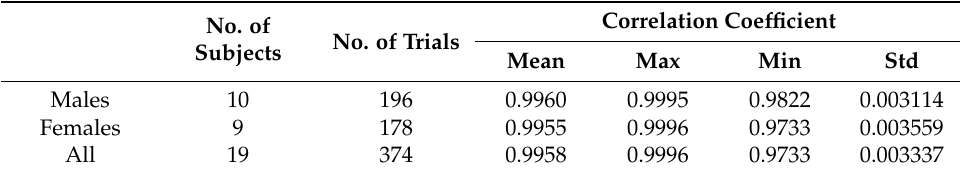
Figure 7. Thigh angle computed from MAL data (𝜃 (cid:3014)(cid:3002)(cid:3013) ) and IMU data (𝜃 (cid:3010)(cid:3014)(cid:3022) ) for a sample trial. Correlation coefficient of the two waveforms is 0.99932 and the root mean square error (RMSE) is 1.0675 for this trial. Table 1. Correlation statistics between θ MAL and θ IMU . Table 1. Correlation statistics between 𝜃 (cid:3014)(cid:3002)(cid:3013) and 𝜃 (cid:3010)(cid:3014)(cid:3022) .